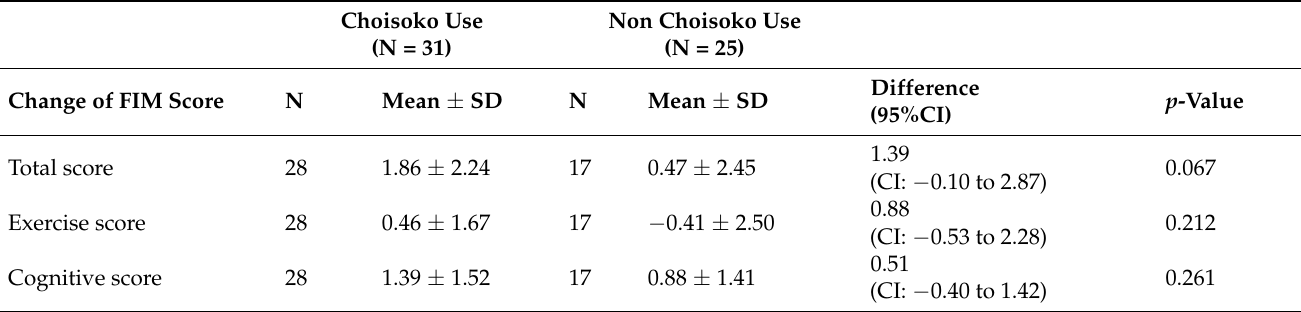
Table 2. Comparisons of FIM score